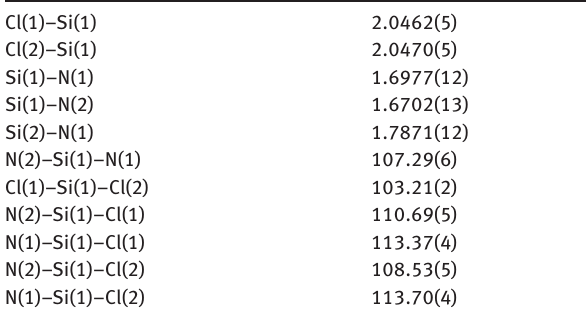
Table 6: Selected geometric parameters (Å, °) of 5d-TMS